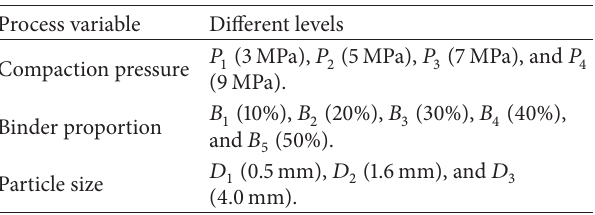
Table 1: Process variables at different levels of the produced water hyacinth briquettes.